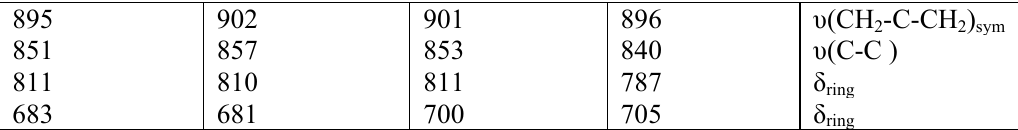
Figure 3. Correlations between the experimental and theoretical frequencies (cm -1 ) obtained by the B3LYP, B3WP91 and HF/6-31G(p) methods.